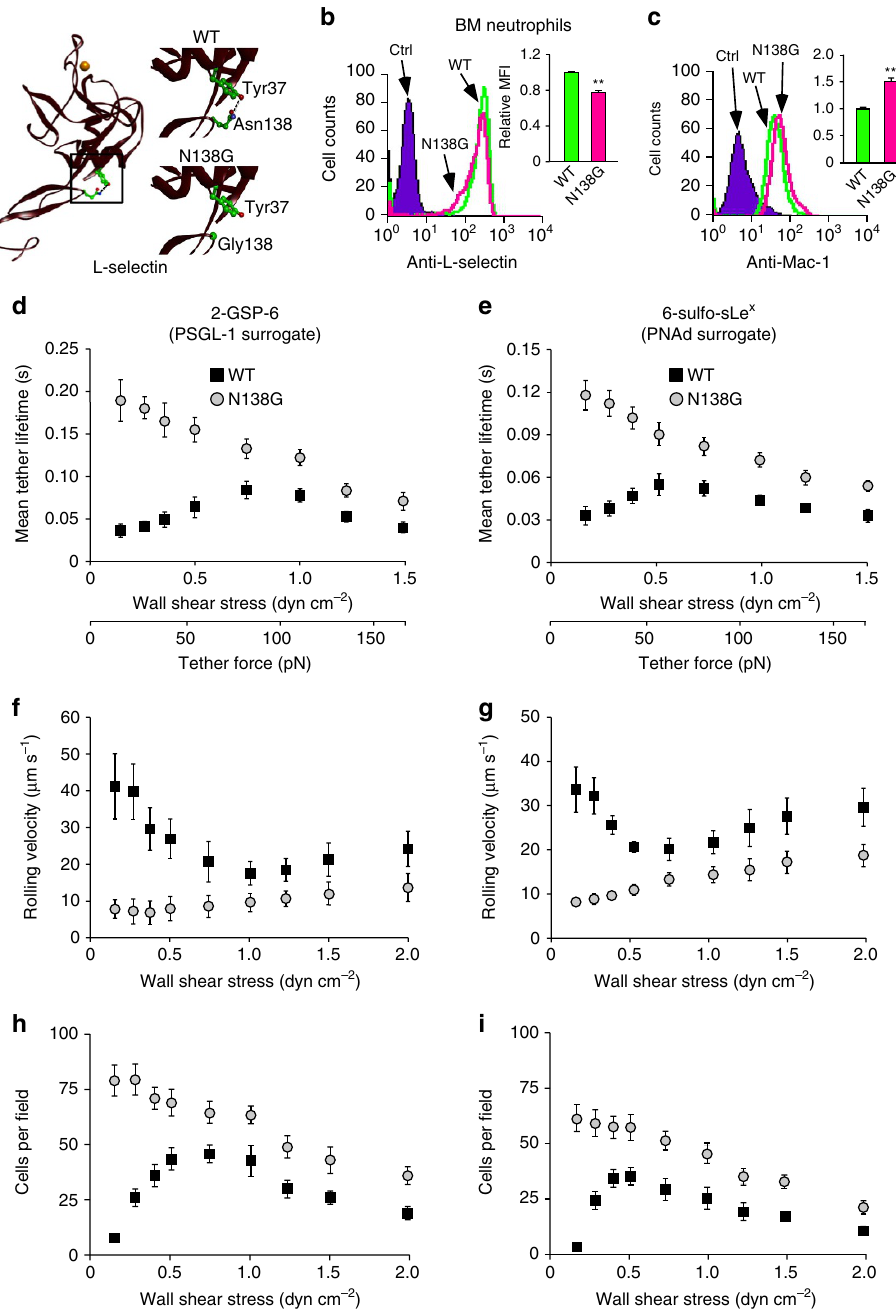
Figure 1 | Altered L-selectin mechanochemistry in N138G mice reduces the shear threshold for neutrophil rolling. ( a ) Left, crystal structure of the lectin and EGF domains of L-selectin (Protein Data Bank entry 3CFW). The gold sphere represents a Ca 2 þ ion in the ligand-binding region of the lectin domain. The boxed area highlights the hinge region magnified in the insets (right). A hydrogen bond (dashed line) connects Tyr37 with Asn138. No hydrogen bond connects Tyr37 with Gly138 in the L-selectin mutant expressed in N138G mice. ( b , c ) Surface expression of L-selectin and Mac-1 on bone marrow (BM) neutrophils of WTand N138G mice. The gating strategy for BM neutrophils is shown in Supplementary Fig. 9. Representative histograms and relative mean fluorescence intensity (MFI) in bar graphs are shown. Data are mean ± s.e.m. of five mice per group. ** P o 0.01 (two-tailed Student’s t test). ( d – i ) Flow chamber assays of L-selectin-dependent interactions of BM neutrophils with 2-GSP-6 (surrogate for PSGL-1) ( d , f , h ) or with 6-sulfo-sLe x (surrogate for PNAd) ( e , g , i ). Transient tether lifetimes on lower ligand density ( d , e ), mean rolling velocities ( f , g ) and rolling cell numbers ( h , i ) on higher ligand density. The data represent the mean ± s.d. from five